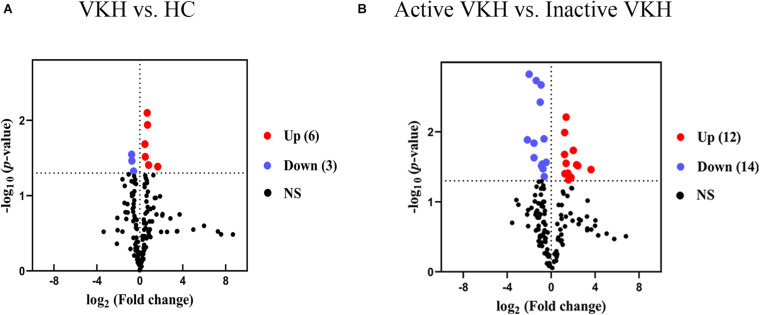
Volcano plots of urinary metabolites. Volcano plots displayed the detected metabolites with log2 (fold change) (x-axis) and -log10 (p value) (y-axis) when comparing VKH with healthy controls (A) and active VKH with inactive VKH (B). The dashed line on y-axis indicated p value = 0.05. The dashed lines on x-axis indicated fold change = 1. The red and blue dots indicate significantly increased and decreased metabolites, respectively. VKH, Vogt-Koyanagi-Harada disease; HC, healthy controls; NS, no significance.